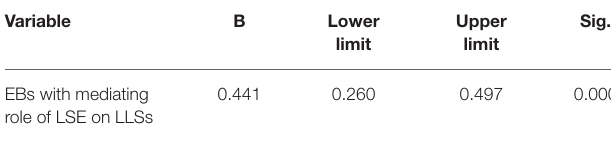
TABLE 9 | Bootstrap estimate of indirect effect of EBs on LLSs with mediating LSE.